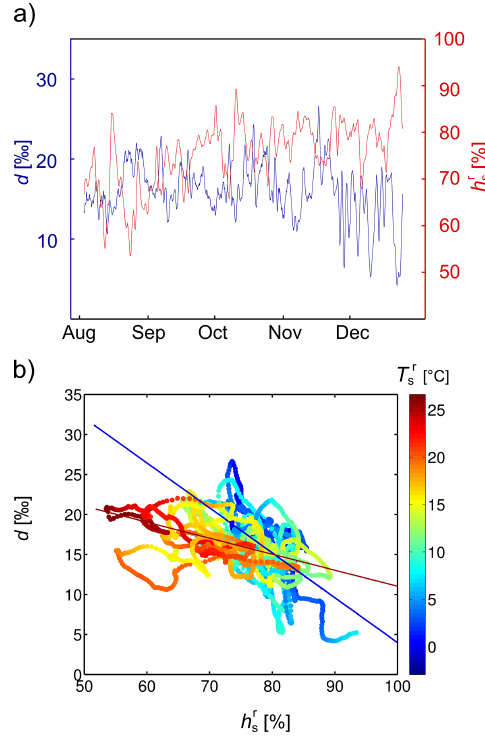
Fig. 7. (a) Time series of 24h moving average filtered d sig- nal (blue) measured between August and December 2011 at Ri- etholzbach and the 24h filtered diagnosed source h r s using COSMO trajectories (red). (b) Scatter plot for the d and h r s signals from panel a. The colour coding indicates skin temperature at the moisture source. The correlation between d and h r s is − 0.47. For the cold sea- son ( T r s < 10 ◦ C) linear regression yields d = − 0 . 57 · h r s + 61 (blue line), which implies an average source d r s of 4‰. For the warm sea- son ( T r s ≥ 10 ◦ C) the linear regression yields d = − 0 . 19 · h r s + 30 with an average source d r s of 11‰ (red